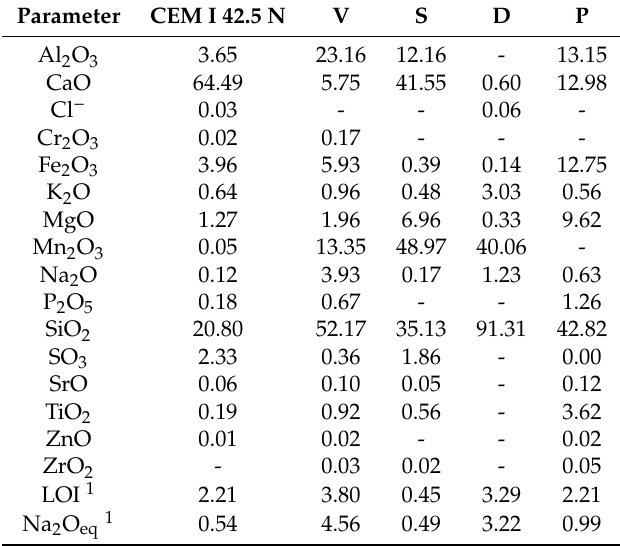
Table 2. Chemical composition of the CEM I, natural pozzolan, P, siliceous coal fly ash, V, silica fume, D, and ground granulated blast-furnace slag,